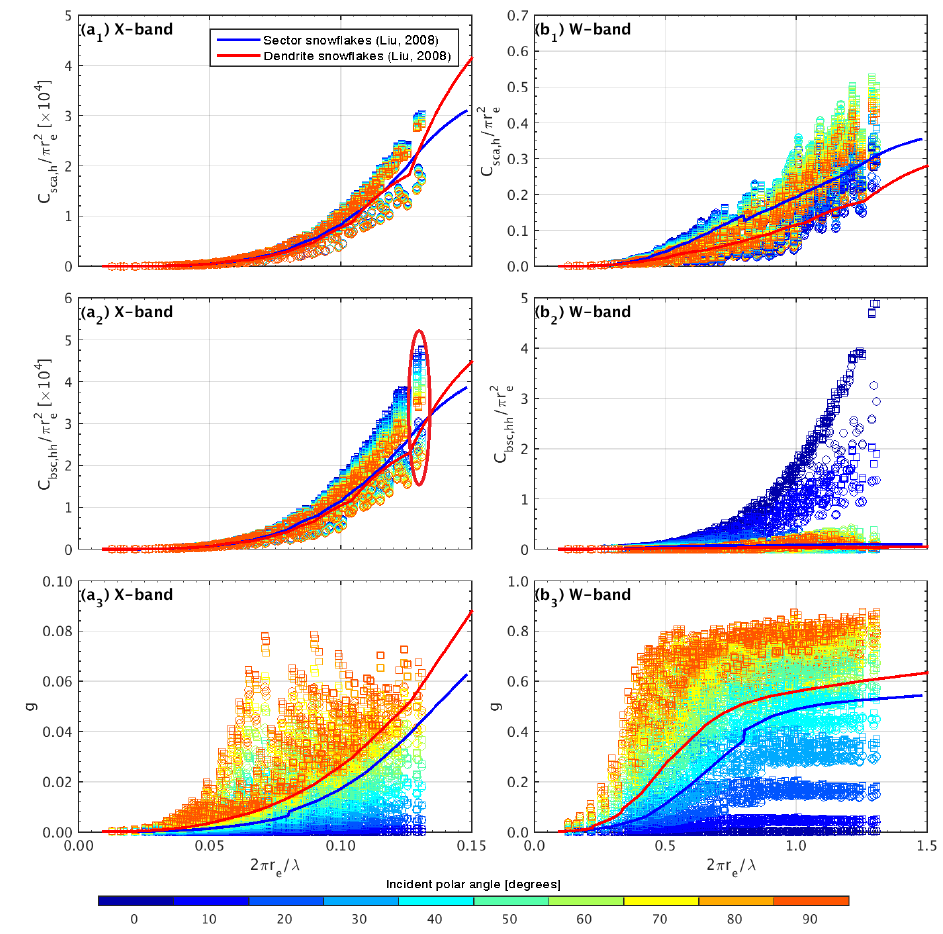
Figure 5. Database branched planar crystal ( a 1 , b 1 ) scattering cross sections, ( a 2 , b 2 ) backscattering cross sections, and ( a 3 , b 3 ) asym- metry parameters for incident h-polarized radiation vs. size parameter 2 πr e /λ , where λ is the wavelength of the incident radiation and r e is the radius of a solid (0.917gcm − 3 ) ice sphere with mass equal to that of the crystal. GMM results are represented by open circles, whereas DDA results are given by open squares. The solid lines represent the results for (blue) sector snowflakes and (red) dendrite snowflakes from Liu